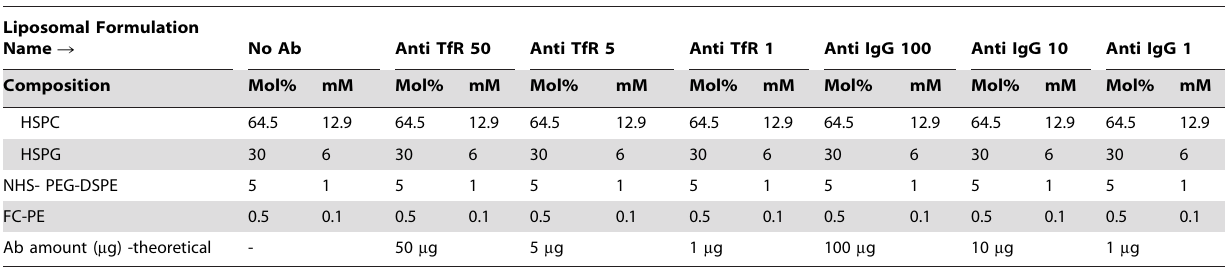
Table 1. Materials used for the various liposomal formulations.